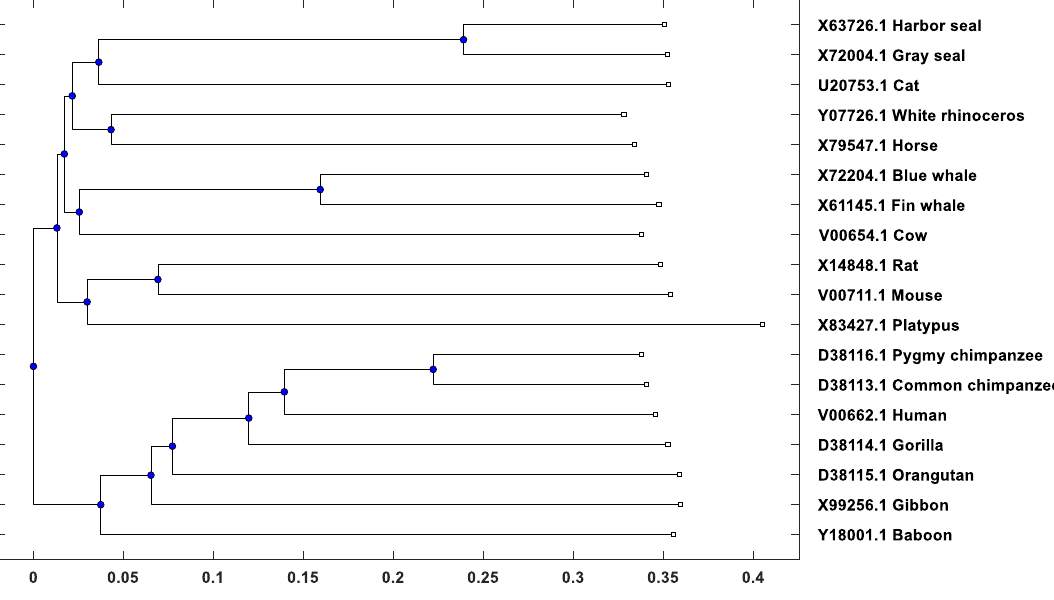
Fig. 6 Phylogenetic tree of 18 Eutherian mammals using our proposed method with k = 8 and S r =